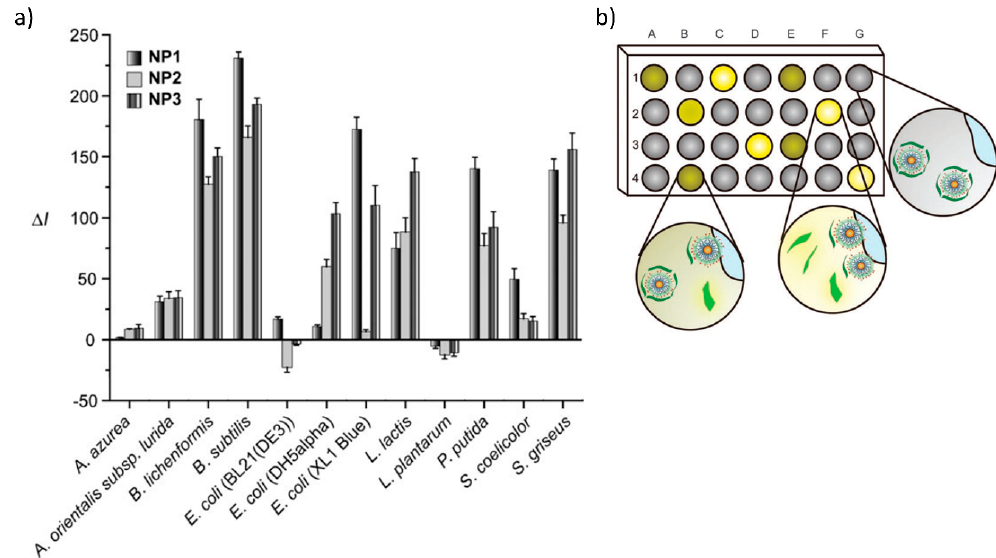
Figure 7. ( a ) Fluorescence intensity patterns of nanoparticle–oligomer (Table 1, no. 14) constructs in the presence of various bacteria strains. ( b ) The schematic presentation of sensor design. Bacteria interact with gold nanoparticle-oligomer construct and as oligomers macromolecules are released to the solution, fluorescence enhancement is observed. For each bacteria, interactions with nanoparticles are unique. In the figure, columns represent bacteria of different types, and rows represent the oligomer–nanoparticle constructs. Reprinted with permission from [69]. Copyright 2008 John Wiley and Sons.